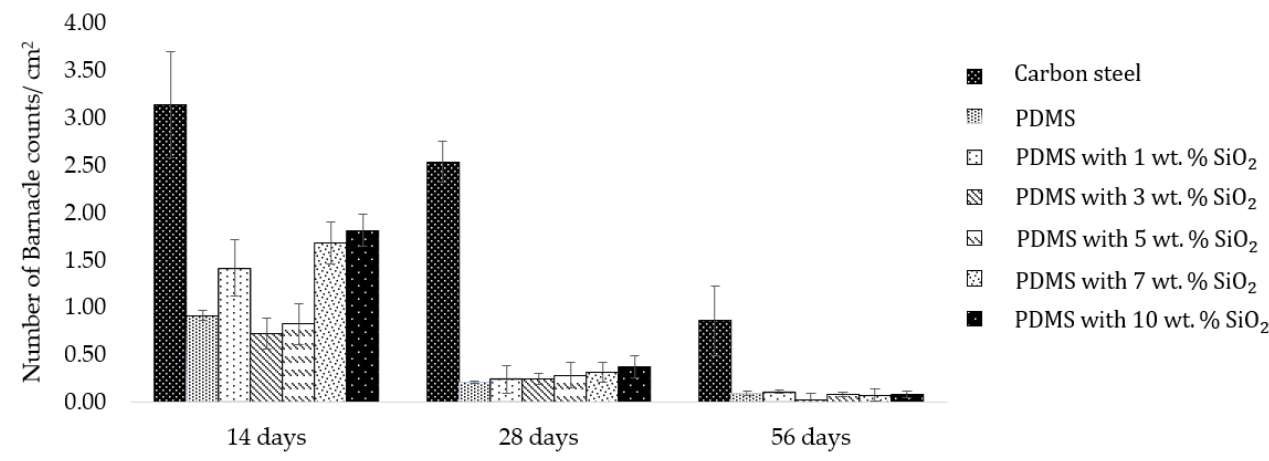
Figure 5. Barnacle counts after 14 days, 28 days and 56 days in seawater (facing away from the shore). Apart from the number of barnacles on the surface, barnacle adhesion strength, which relates to the barnacle release property, was also another significant factor linked to an- tifouling application that was investigated. Barnacle adhesion strength was calculated by dividing barnacle adhesion force with the barnacle base area. The result showed that the PDMS with 3 wt.% SiO 2 composite exhibited lower barnacle adhesion strength,